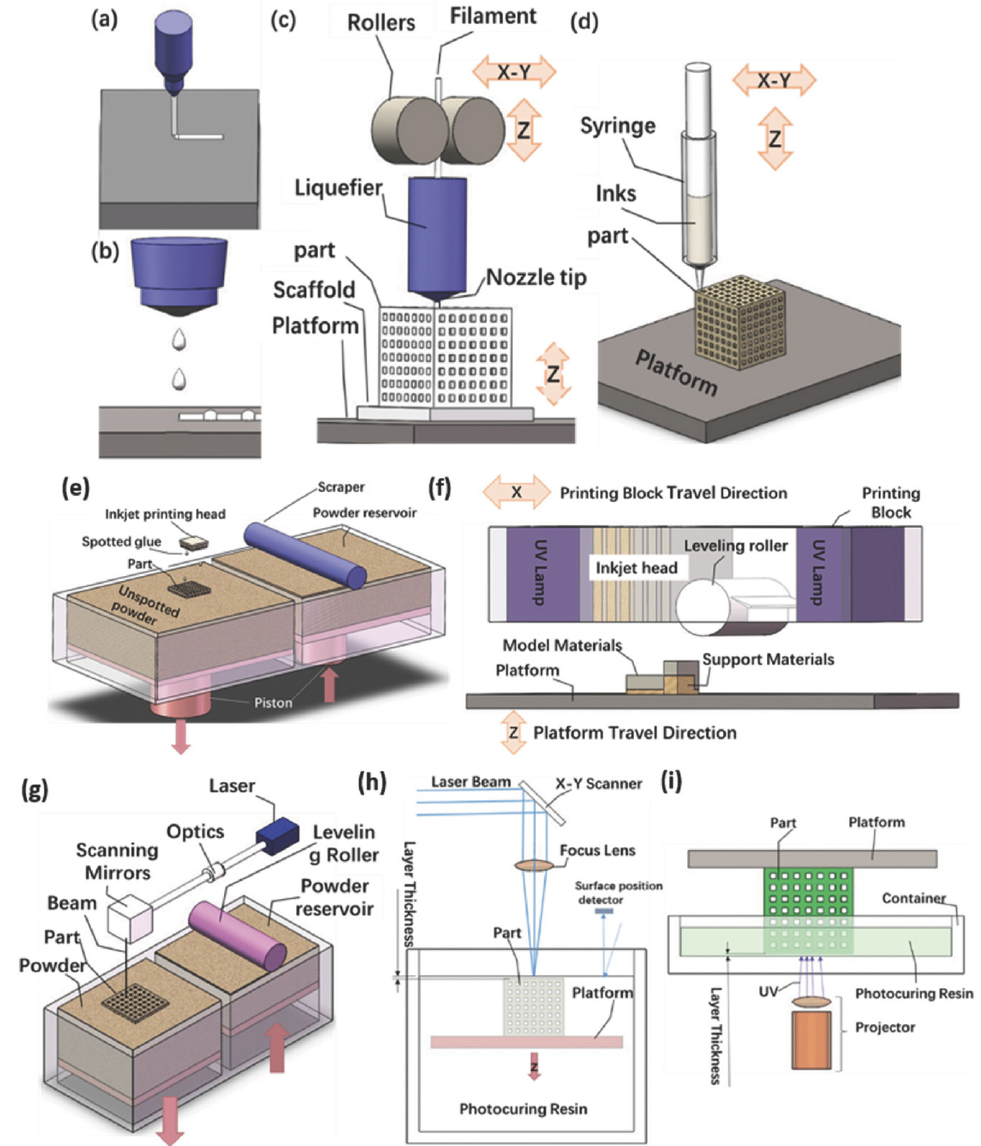
Figure 2. Principles of AM methods: ( a ) continuous filament writing, ( b ) droplet jetting, ( c ) fused deposition modeling, ( d ) inkjet printing, ( e ) the powder bed inkjet 3D printing, ( f ) multijet 3D printing, ( g ) selective laser sintering, ( h ) free-surface stereolithography, and ( i ) constrained-surface stereolithography [6].